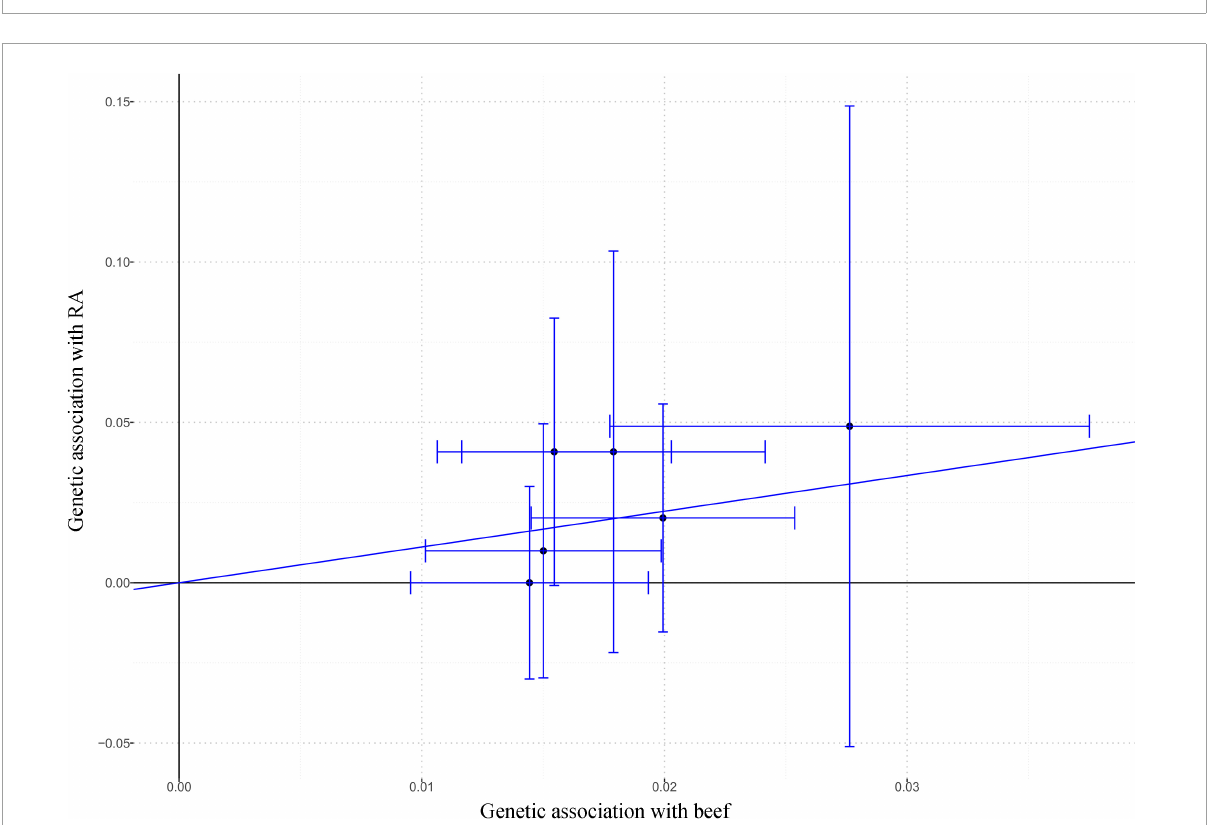
FIGURE3 The effect size and 95% CI of each SNP on the association between beef intake and RA risk by IVW. Abbreviations: CI, confidence interval; IVW, inverse-variance weighted; RA, rheumatoid arthritis; SNP, single nucleotide polymorphism.